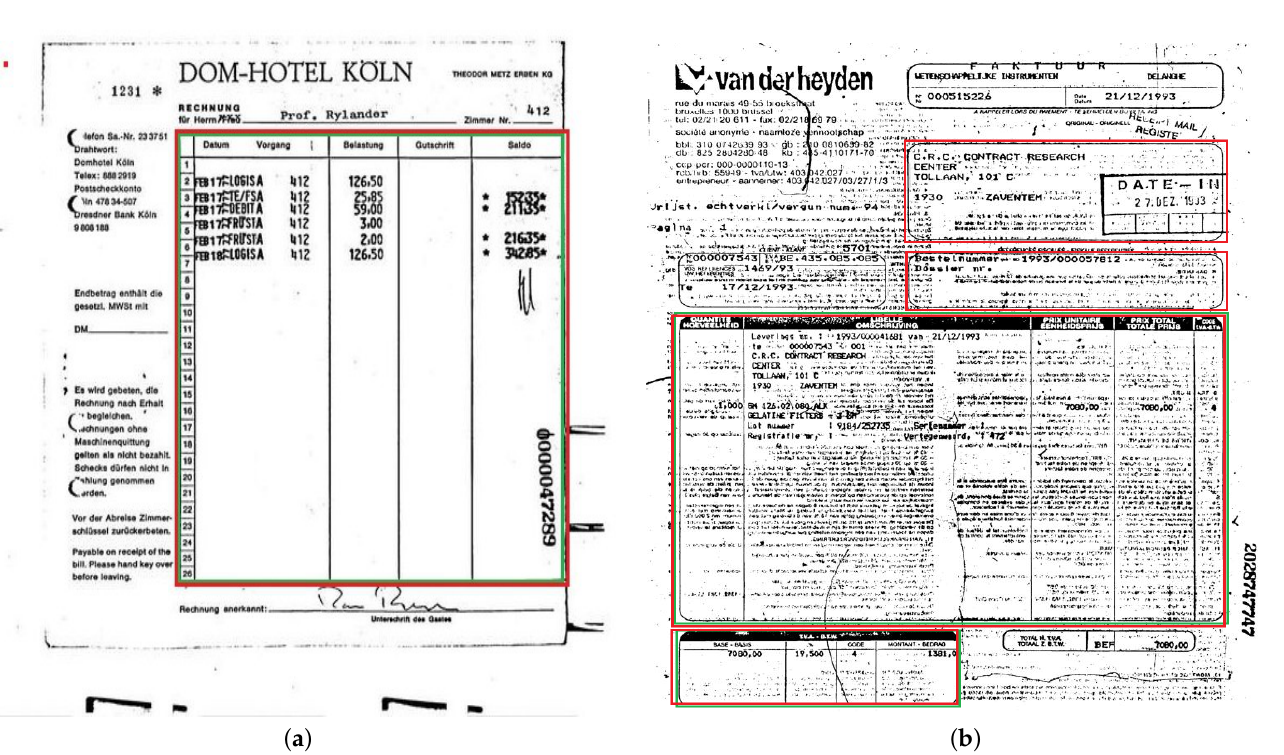
Figure 13. Some sample images from RVL-CDIP showing: ( a ) true positve and ( b ) false positive. The green region represents the ground truth bounding boxes while the red region represents bounding boxes of detected